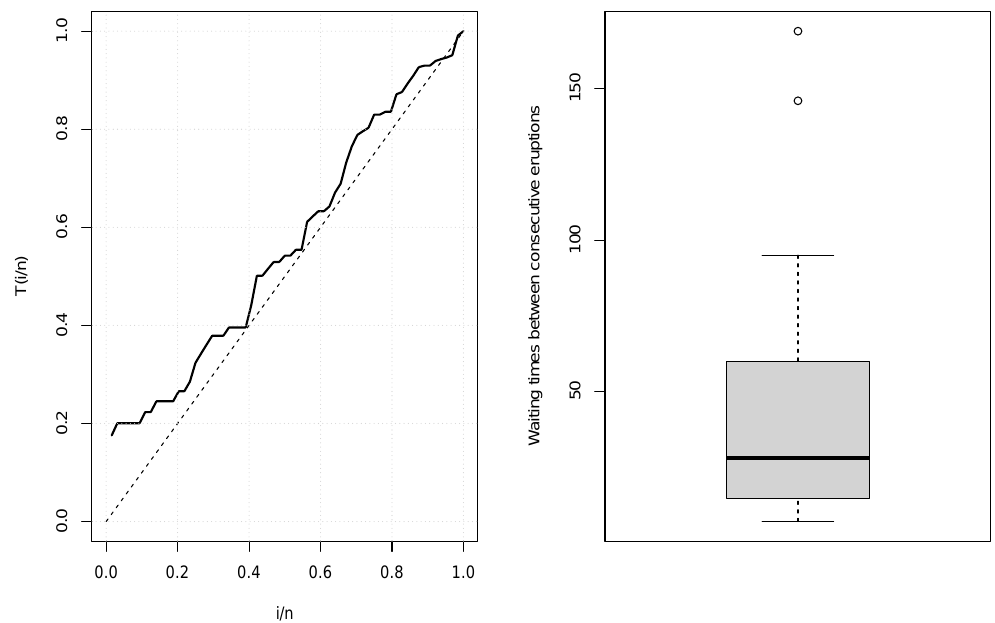
Figure 5. TTT plot ( left ) and box plot ( right ) for the Kiama Blowhole data. Table 3. ML estimates, SEs (in parentheses), and goodness-of-fit-measures of the models for the Kiama Blowhole